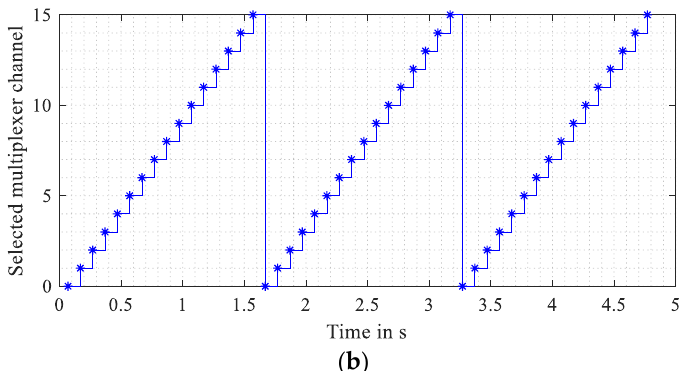
Figure 22. Multiplexer channels during the scanning phase ( a ) Receiving coil on the top of C15 ( b ) No receiving device is present.